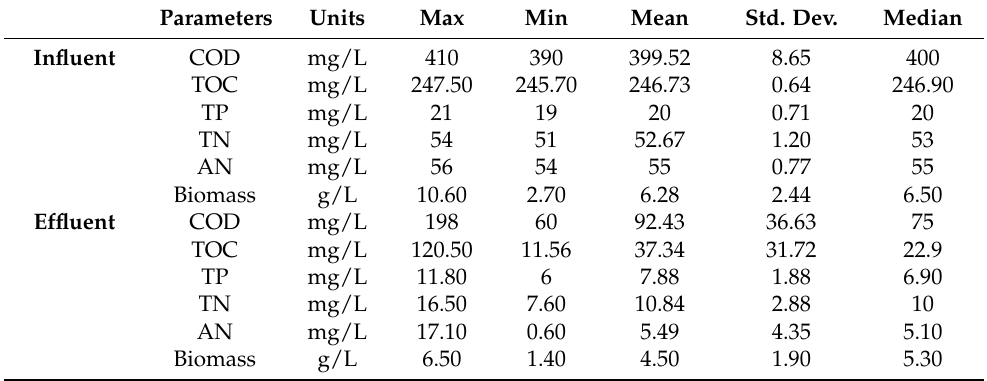
Table 1. Influent and effluent parameters statistical